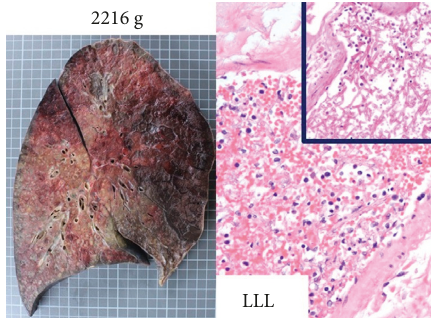
Figure 2: Postmortem autopsy findings revealed significantly congested lungs with infarction and necrosis. Histopathological hematoxylin-eosin stain showed abundant angioinvasive, aseptate hyphae, consistent with mucorales, in the left lower lung (LLL).